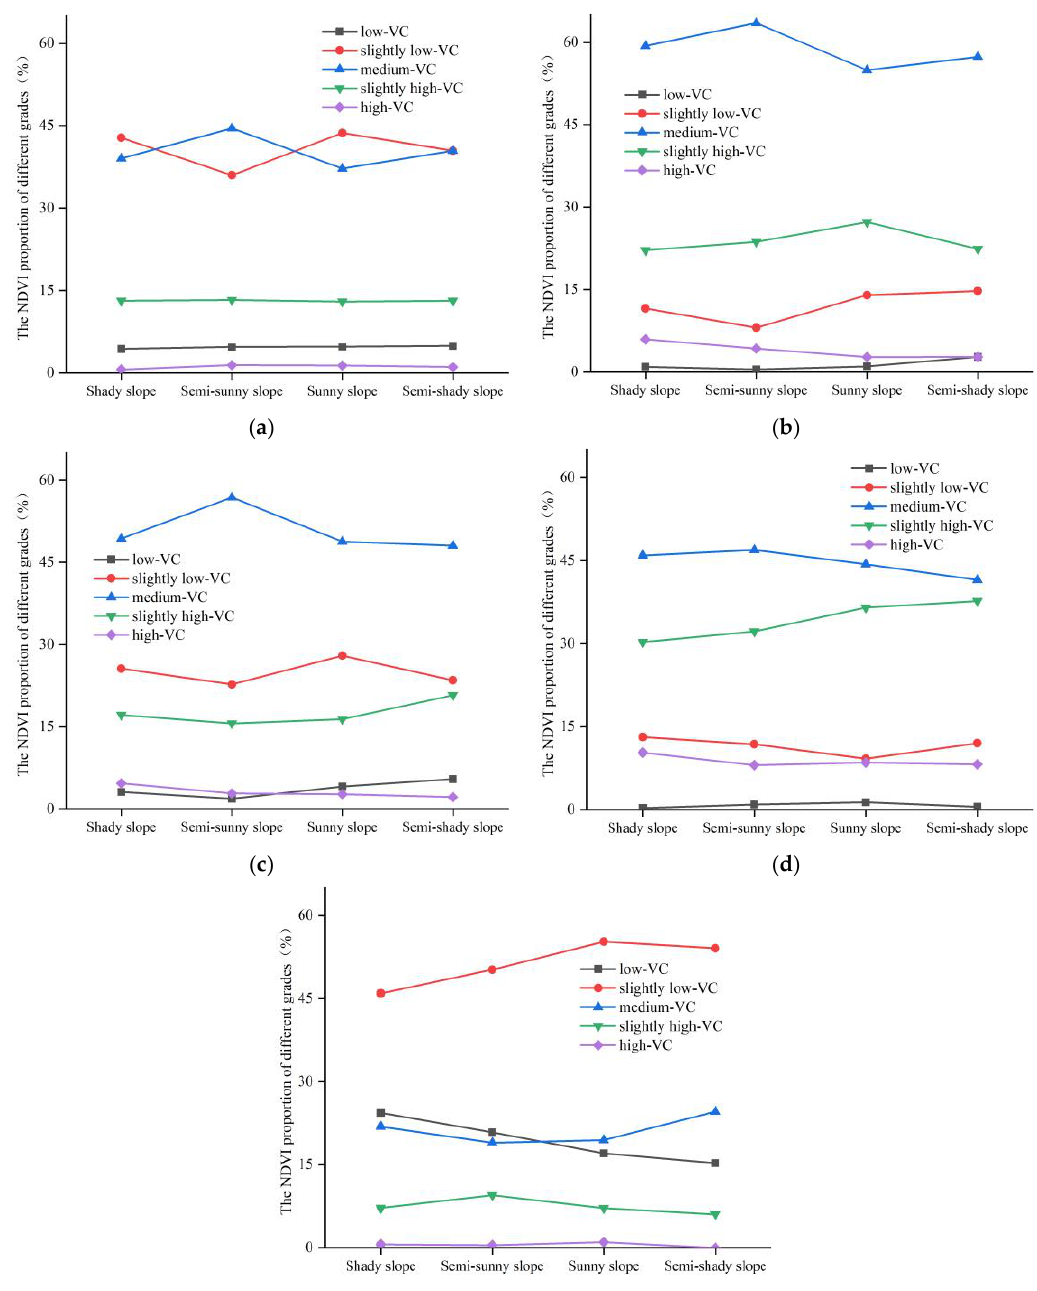
Figure 18. The proportion of different vegetation cover grades on different aspects: ( a ) 2017; ( b ) 2018; ( c ) 2019; ( d ) 2020; ( e ) 2021.